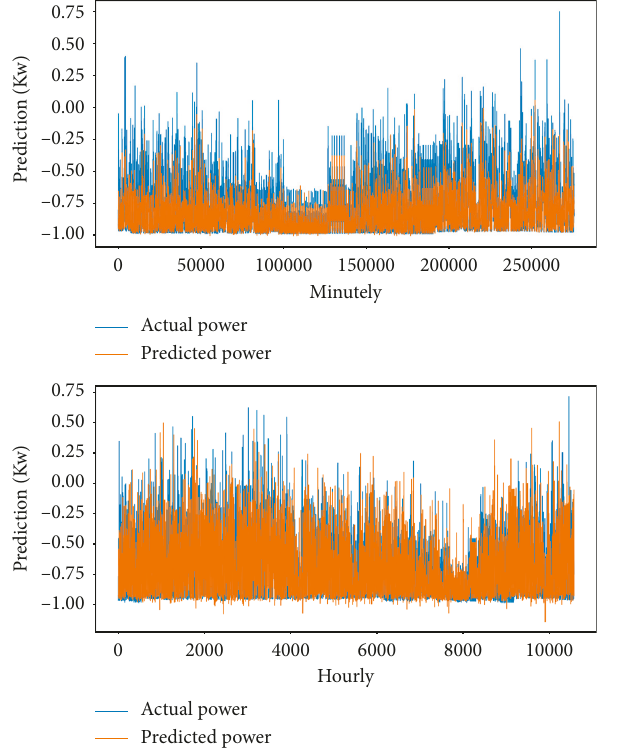
Figure 9: Visual representation of CNN-GRU-based forecasting results considering minute and hour horizons on the household power